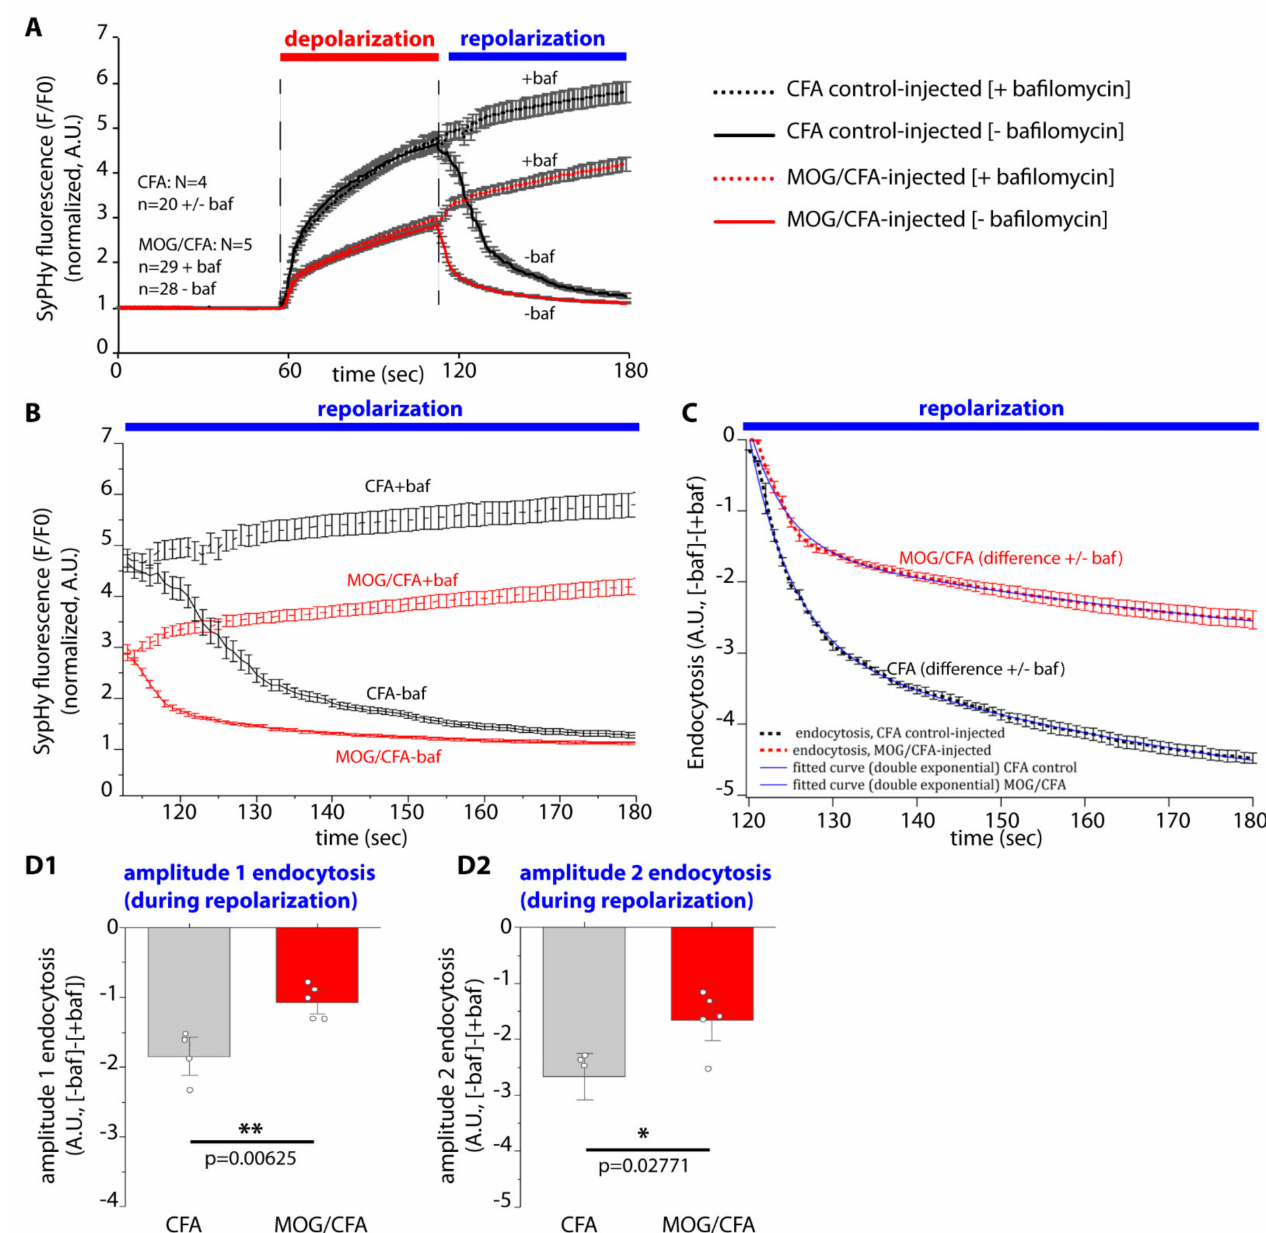
Figure 8. Post-stimulus endocytosis is decreased in MOG/CFA-injected early EAE mice in comparison to CFA-injected control mice. ( A ) Optical recording of SypHy response measurement in the presence and absence of bafilomycin A1 in the OPL of MOG/CFA-injected EAE mice and CFA-injected control mice on day 9 after injection. ( B ) SypHy responses in the OPL of MOG/CFA-injected EAE mice and CFA-injected control mice during the repolarization phase (120–180 s) in the presence ([+baf]) or absence ([ − baf]) of bafilomycin-A1. In ( C ), the curves from ( B ) in the presence of bafilomycin A1 were subtracted from the curves in the absence of bafilomycin A1 ([ − baf]-[+baf]) to obtain the values for endocytosis for CFA-injected control mice and MOG/CFA-injected EAE mice. Data points in ( C ) could be fitted best by a double-exponential curve from which the amplitudes of fast and slow endocytosis during the recovery phase were extracted ( D ). Values in ( D1 , D2 ) are means ± S.E.M. from amplitude 1 and amplitude 2 respectively. Unpaired Student’s t -tests were used to determine the statistical significance. N, number of mice; n, number of retinal slices used for optical recording in the presence/absence of bafilomycin A1; **, p ≤ 0.01; *, p ≤